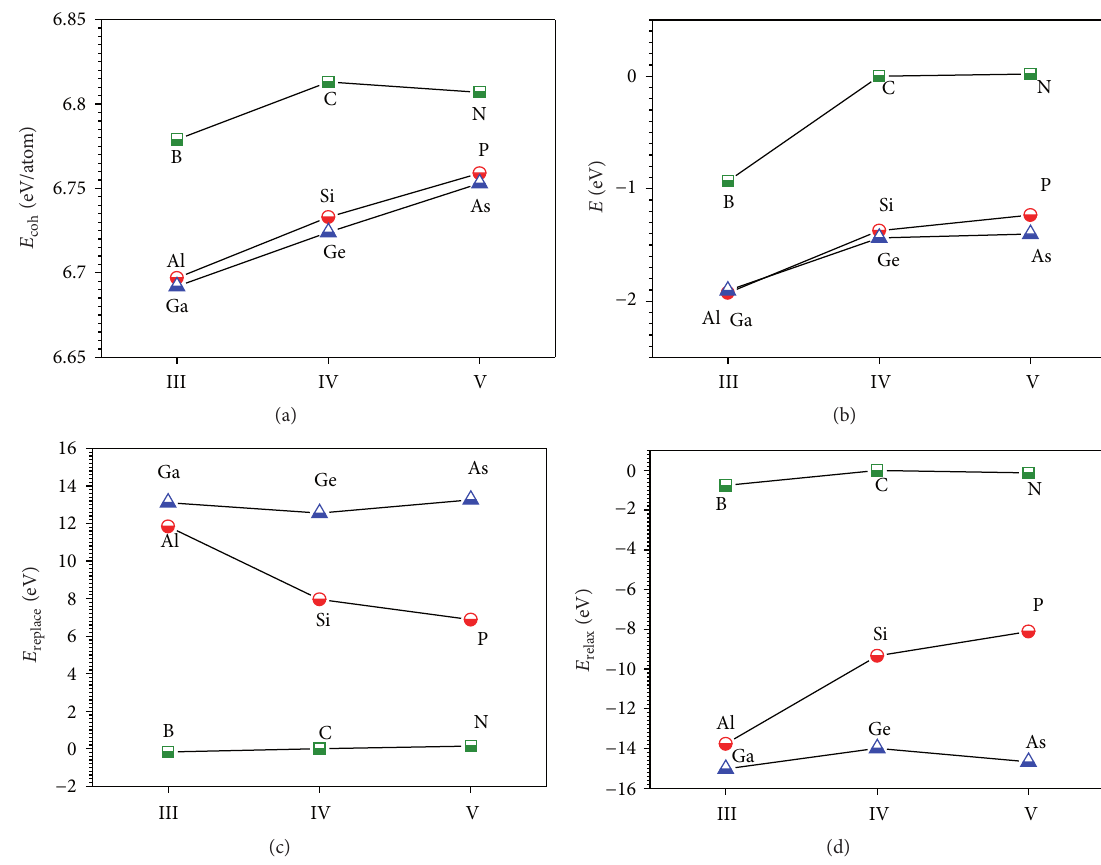
F 2: e obtained energies of the doped and pristine carbon cages.